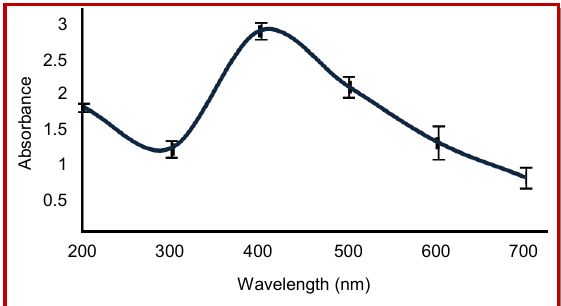
Figure 2: UV-visible absorption spectra of silver nanoparticles synthesized from Sargassum polyphyllum . Values are the mean of n = 3 (mean ± Standard error)